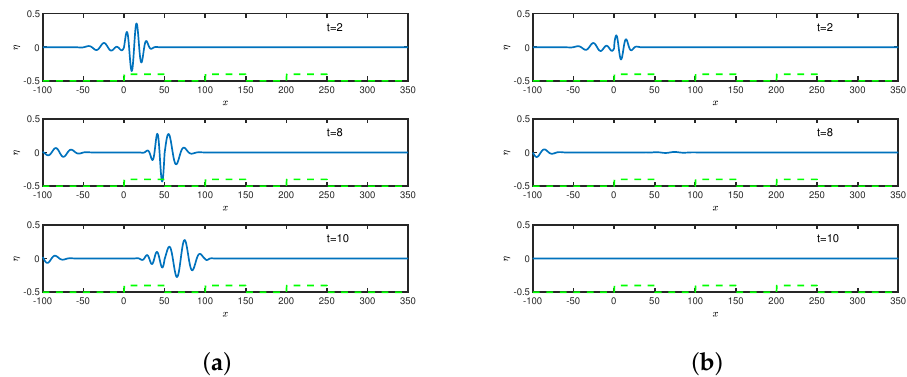
Figure 13. Free surface elevation η ( x , t ) versus spatial variable x ( a ) without friction coefficient C f = 0 and ( b ) with friction coefficient C f = 0.32 for N = 3 with h 1 = 5 m, θ = 0 ◦ , h 2 / h 1 = 0.4.